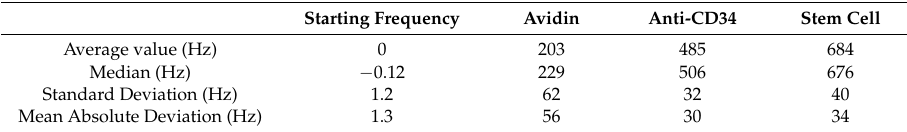
Table 2. Average frequency shift values obtained from the three independent replicas.